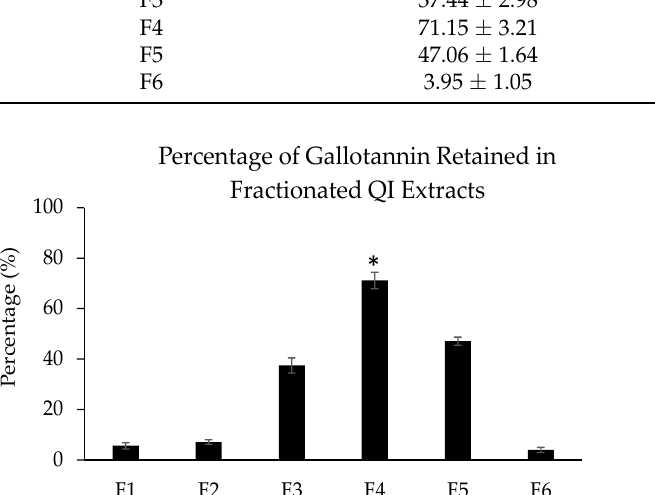
Figure 5. Percentage of the gallotannin compound retained in the fractionated QI extract (F1 to F6) (* p < 0.05 for F4 vs. all other fractions).